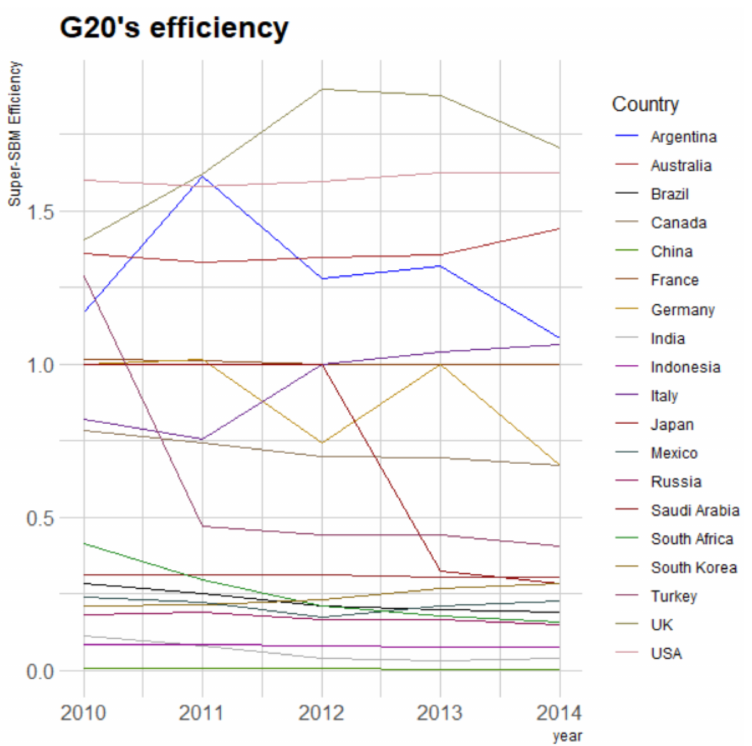
Figure 3. Five-year average energy efficiencies.